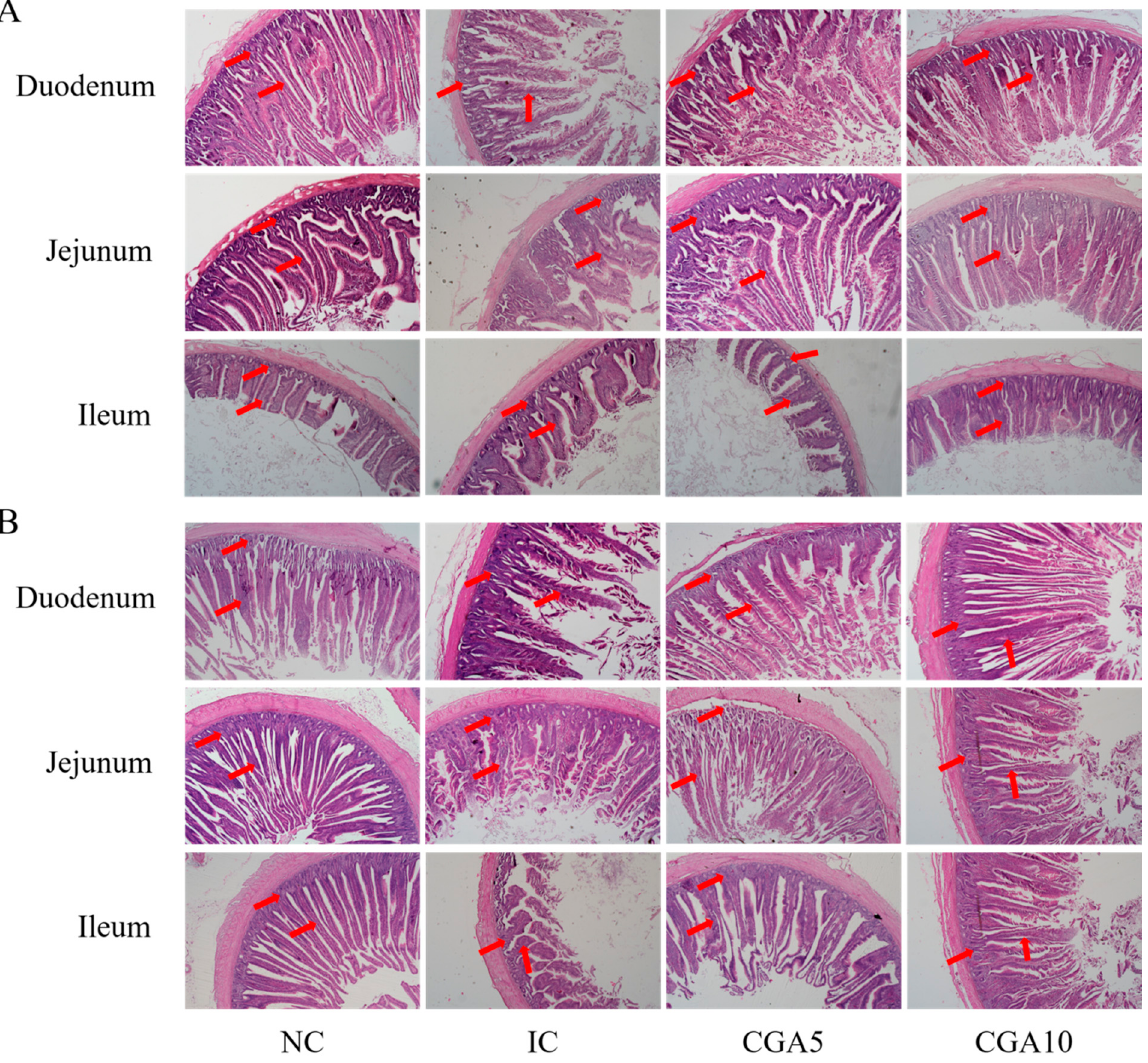
Figure 1. Effects of chlorogenic acid (CGA) on the intestinal morphology of broilers ( n = 6). ( A ) Day 21, ( B ) day 42. NC: Control diet; IC: Control diet + Eimeria infection; CGA0.5: Control diet + 0.5 g/kg CGA + Eimeria infection; CGA1: Control diet + 1 g/kg CGA + Eimeria infection. Images in the transverse section (Hematoxylin and Eosin stained) were captured at 100× magnification.